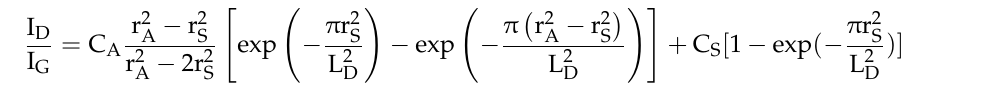
Figure 6. The Raman spectra of the graphene in the G-M contact windows before and after annealing.